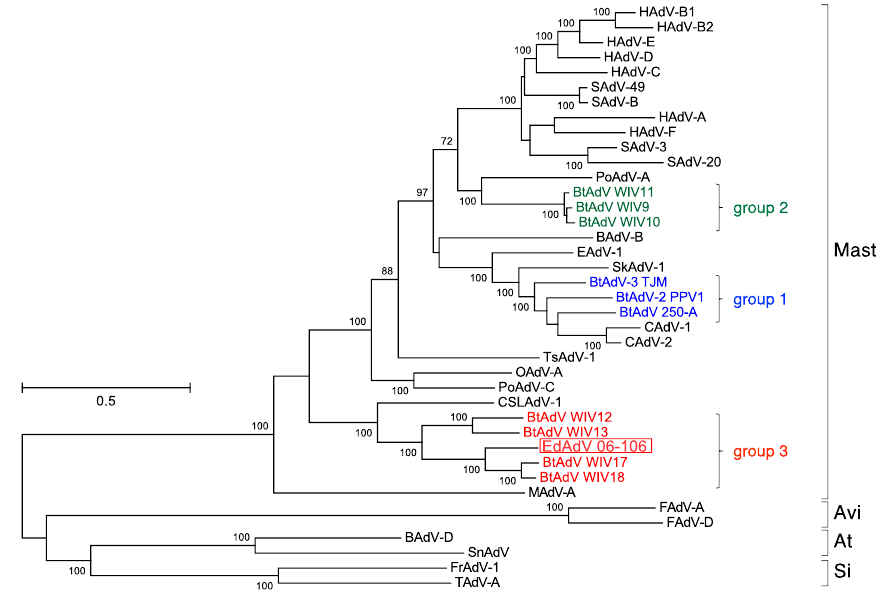
Figure 3. Maximum-likelihood phylogenetic trees based on the full-length of adenovirus genome. The dendrogram was constructed with the general time-reversible model with gamma distribution and invariable sites, with the highest log likelihood (−506,682.7635). The percentage at nodes are bootstrap probabilities that were calculated using 1000 replicates and indicate bootstrap supports >70%. Adenovirus genomes compared with EhAdV 06-106 were listed in Table S1. Bat adenoviruses are shown in colors. Open rectangle indicates EhAdV 06-106. Bar indicates the number of substitutions per site. Abbreviations: Mast, Mastadenovirus ; Avi, Aviadenovirus ; At, Atadenovirus ; Si, Siadenovirus .